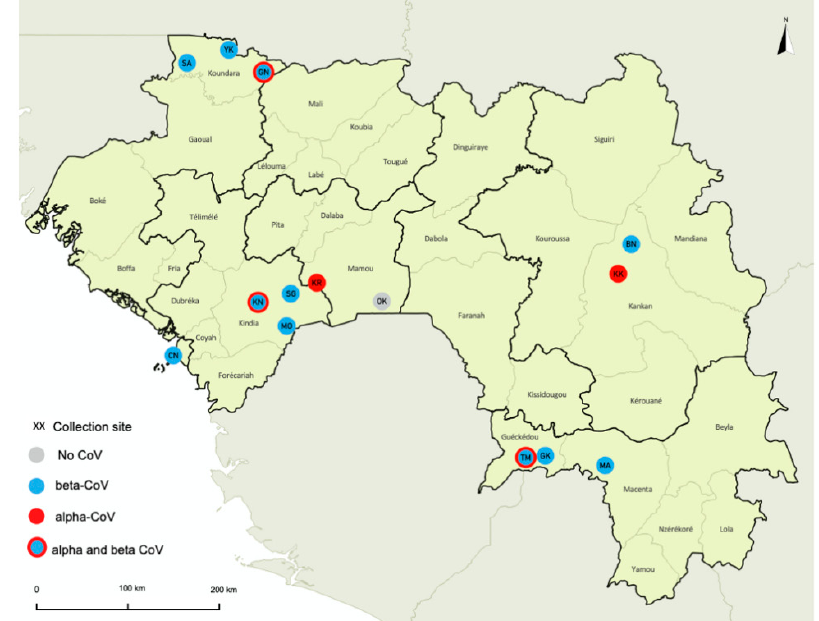
Figure 1. Bat collection sites in Guinea. Sites where samples from bat were collected are highlighted with circles on the map as follows: gray indicates site where no coronavirus (CoV) was detected; red, sites where alphacoronavirus ( α -CoVs) were detected; blue, sites where betacoronavirus ( β -CoV) were detected, blue and red, sites where both α -CoVs and β -CoVs were detected. Sites are